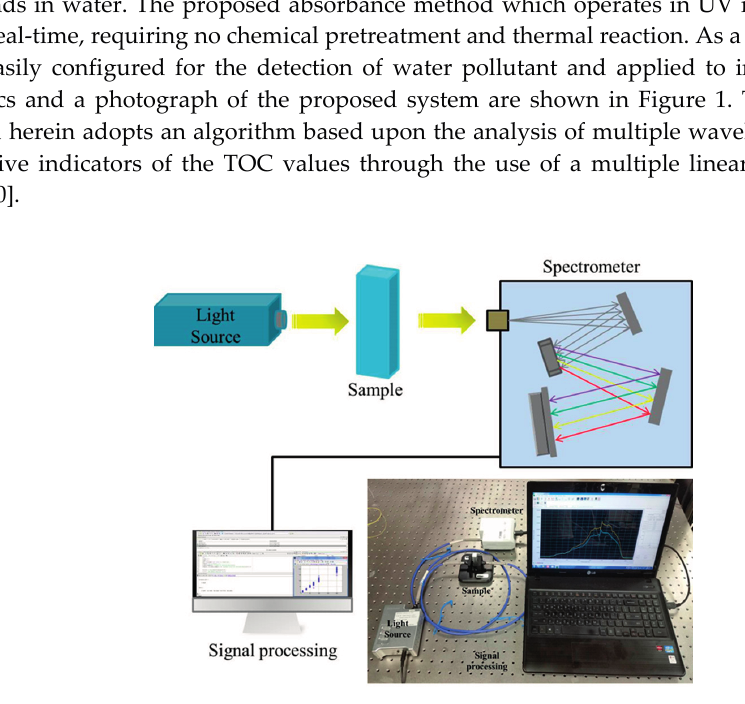
Figure 1. A schematic diagram of the proposed optical system for UV